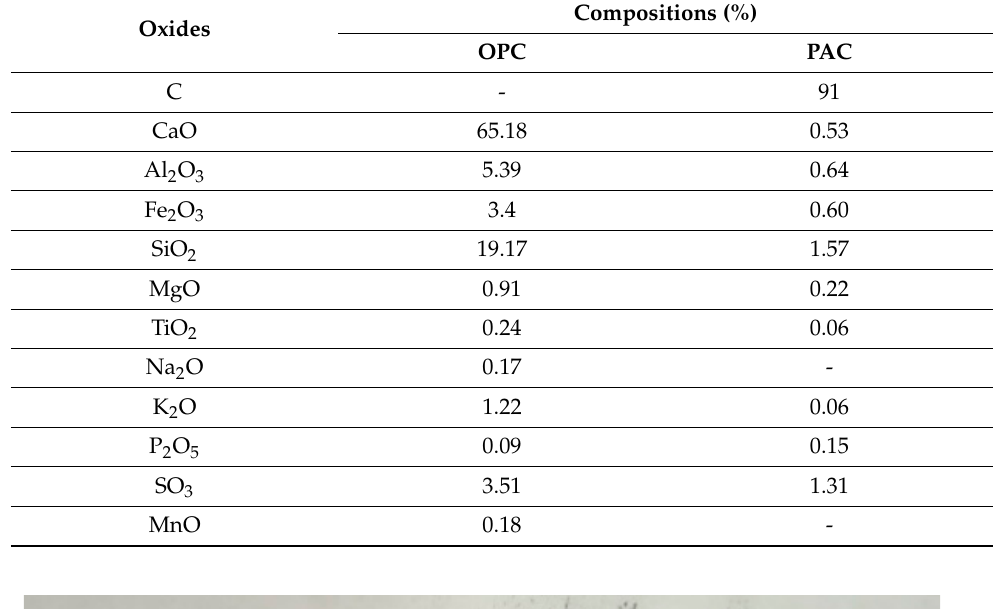
Table 1. Chemical properties of binder materials [17].